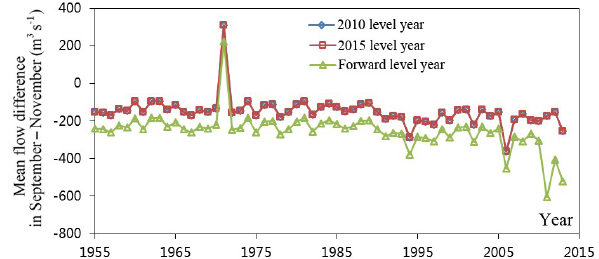
Figure 12. Process of mean flow of Wulong hydrological station from September to November in different level years and the natural